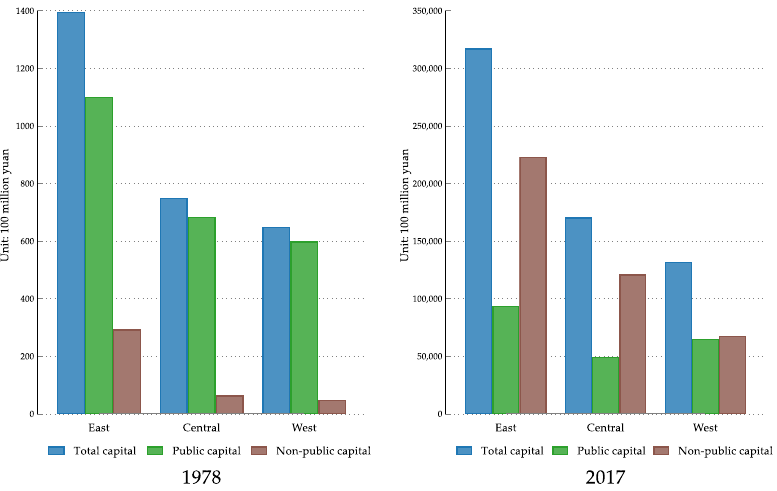
Figure 8. Capital distribution in eastern, central, and western regions.